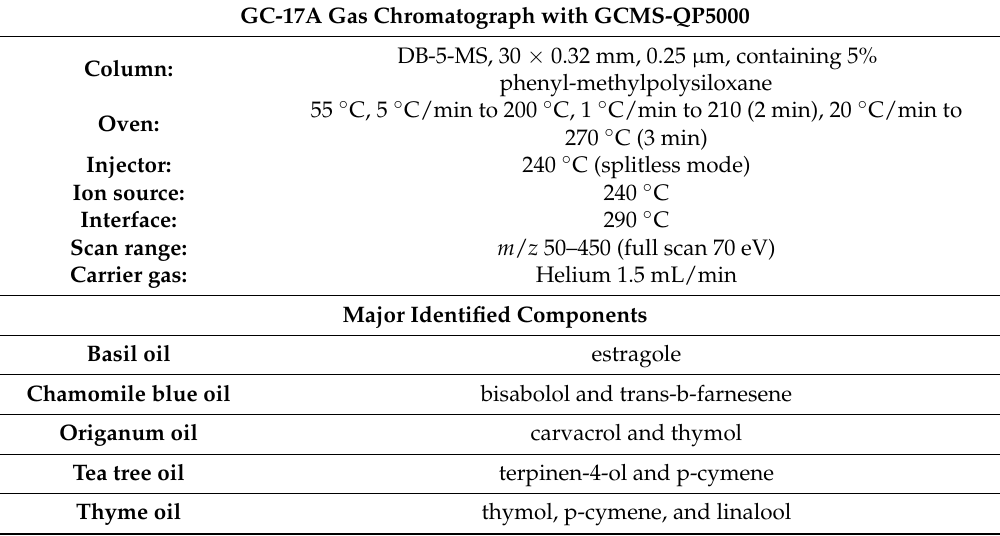
Table 1. Chromatographic conditions and major identified components of the studied essential